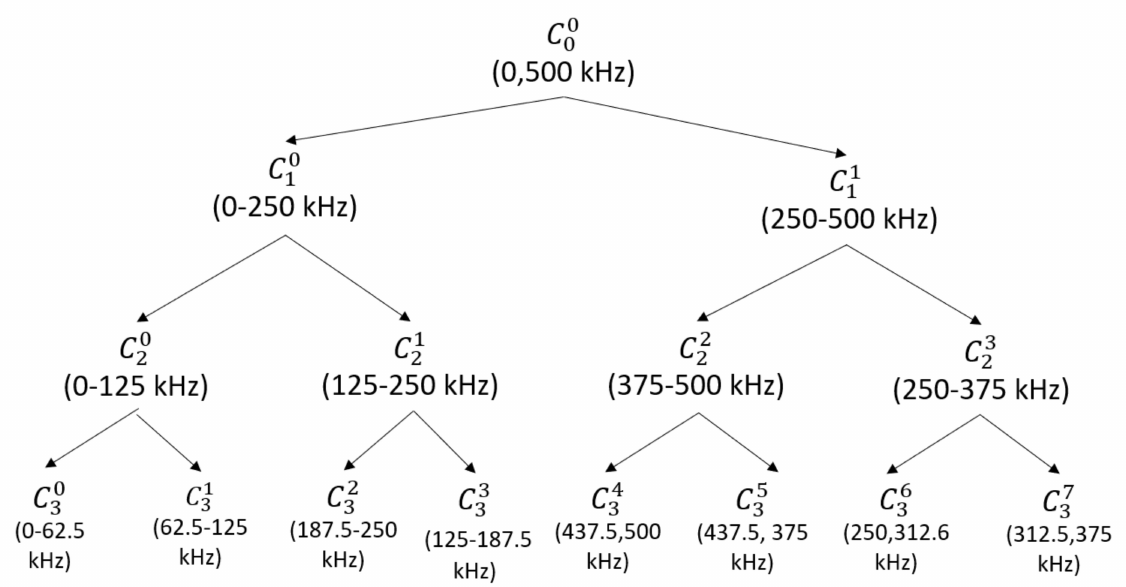
Figure 2. WPT levels, nodes and corresponding frequency